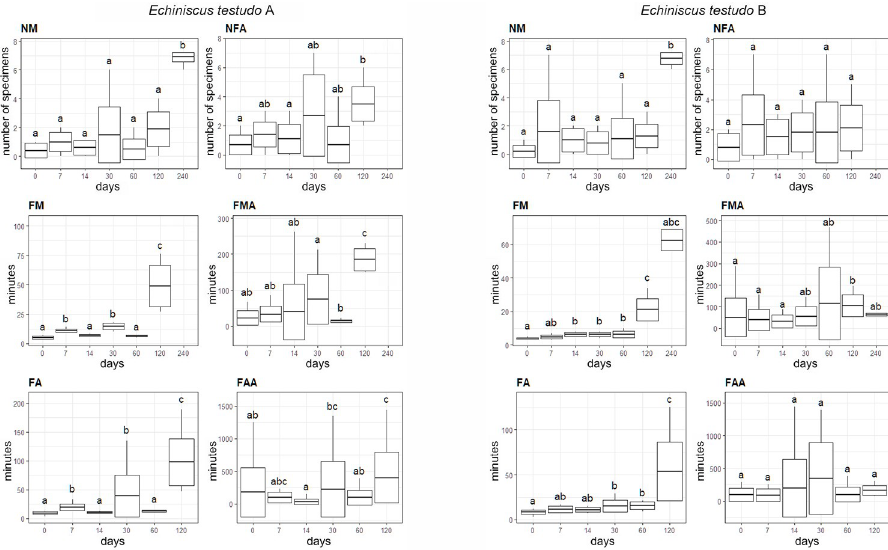
Fig 2. Differences in the number of nonmoving (NM) and not fully active (NFA) individuals, timing of the first movement of any individual (FM) and all moving individuals (FMA), full activity of any individual (FA) and full activity of all active individuals (FAA) between particular treatments (horiziontal axis—days in anhydrobiosis) in two populations of Echiniscus testudo : A—urban habitat, B—population from surroundings of the Wielkopolski National Park. Letters above the boxes (a, b, c, d) denote lack of significant (p < 0.05) differences between groups marked with the same